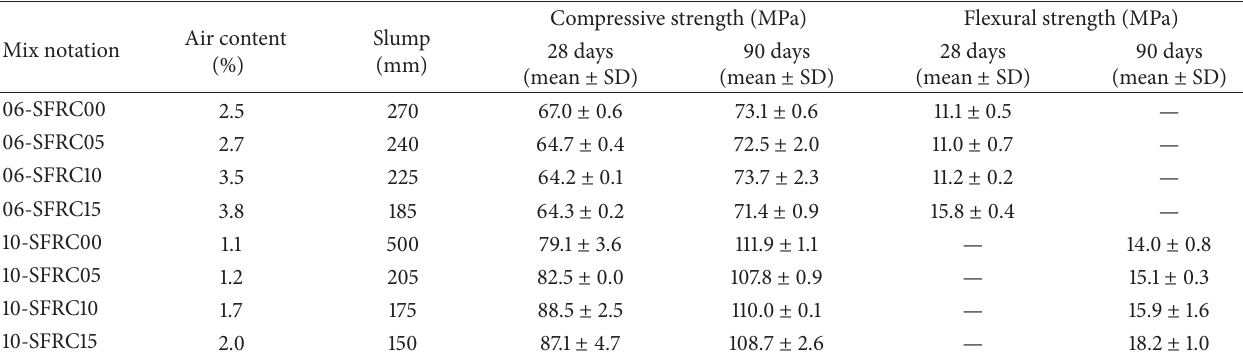
Table 2: Mechanical properties of HPCs used in the